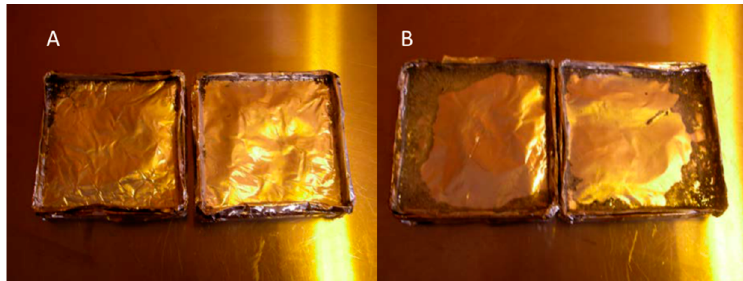
Figure 4. Final char of composites, A. Virgin HDPE and B. HDPE with 0.6% CNC-ZnO.